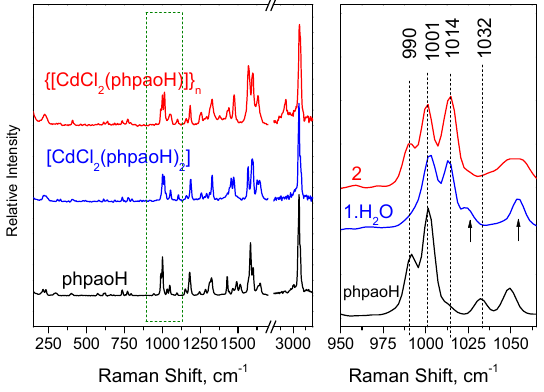
Figure 7. The FT-Raman spectra of compounds phpaoH, 1 ∙ H 2 O, and 2 .